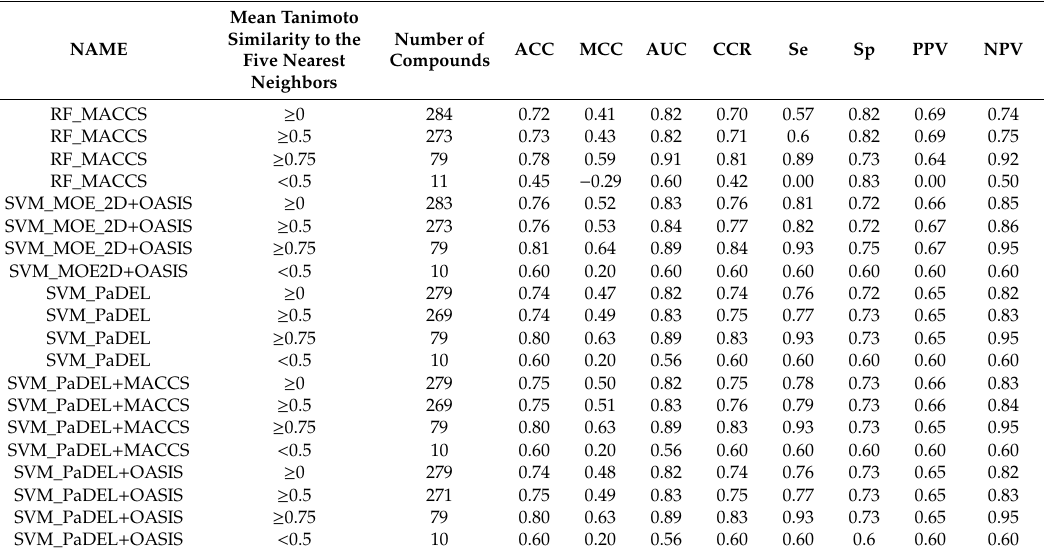
Figure 9. Matthews correlation coefficient (MCC) as a function of the number of consecutive nearest neighbors in the training data that are of the same activity class as the predicted class for a compound of interest (molecular similarity quantified as Tanimoto coefficient based on MACCS fingerprints). The number of compounds in each bin is summarized in Table S9. The graphs for SVM_PaDEL + OASIS and SVM_PaDEL + MACCS are not shown because they are (almost) identical with that of SVM_PaDEL and would overlap. Table 6. Performance of selected models on the test